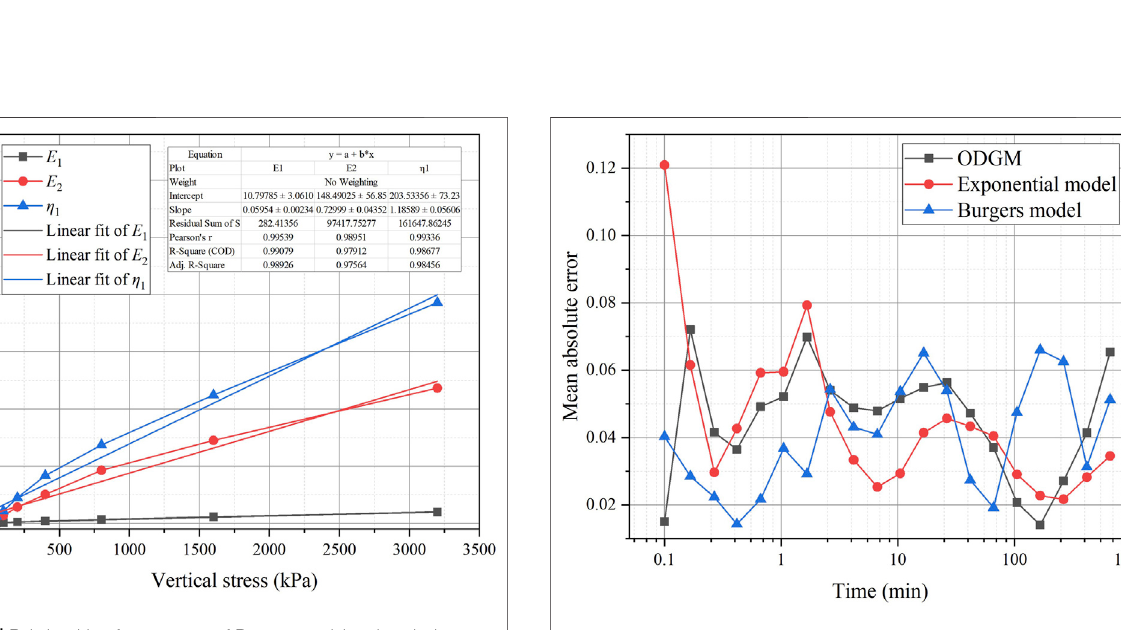
FIGURE 8 | Relationship of mean absolute error and time (log-scale) of three models in the process of self- fi tting.